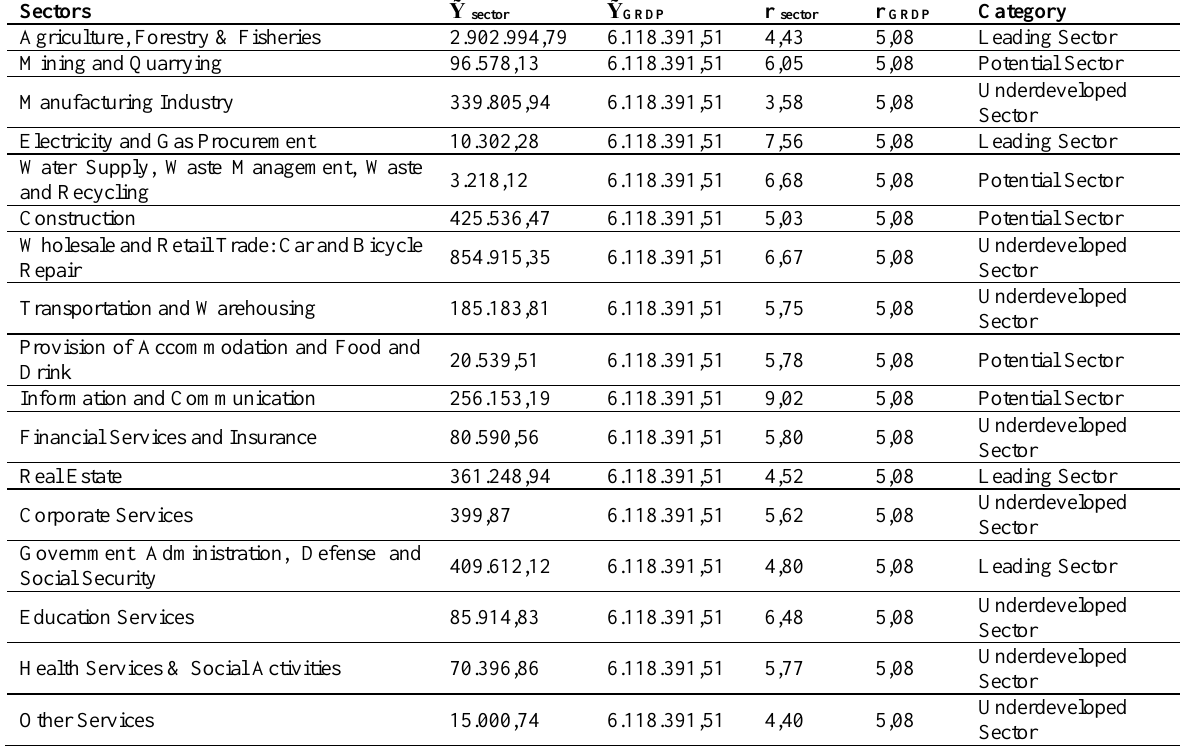
Table 4: Classification of Each Business Sector Based on Klassen's